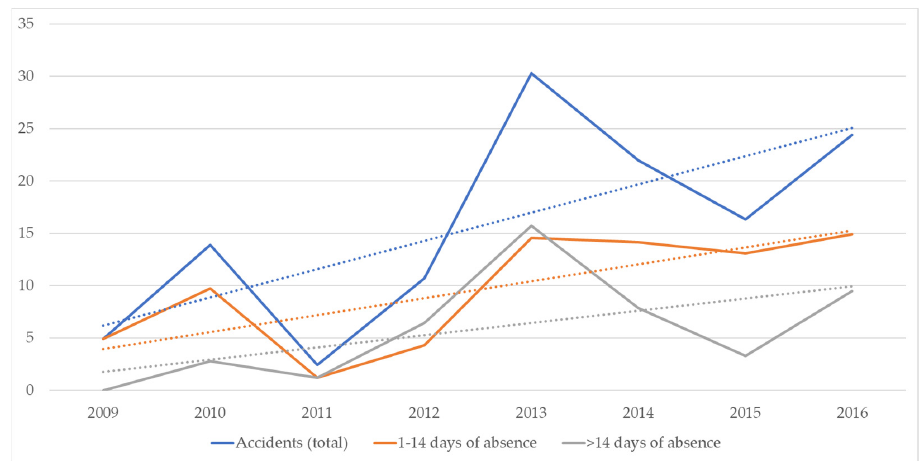
Figure 6. Incidence rates in construction of railways and underground railways. Based on data from [17 – 24,27] .